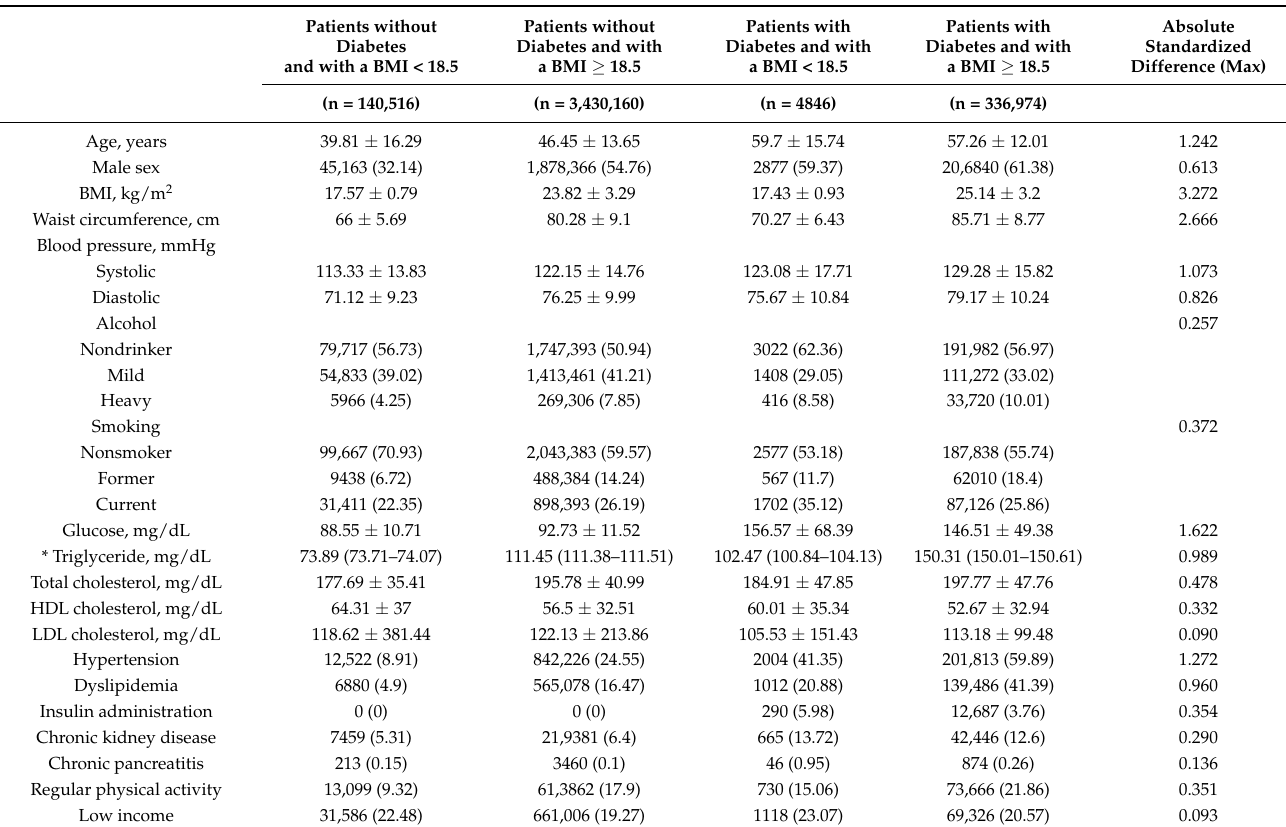
Table 1. Baseline Characteristics.